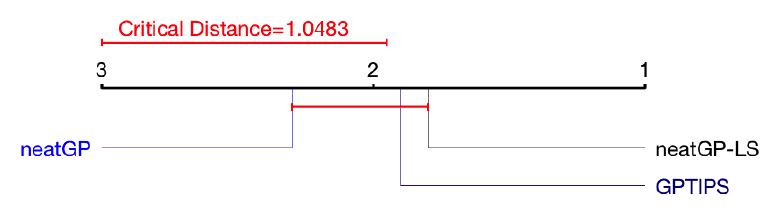
Figure 4. Critical Difference Diagram (CDD) of the Friedman test for the 1–10 scale problem.